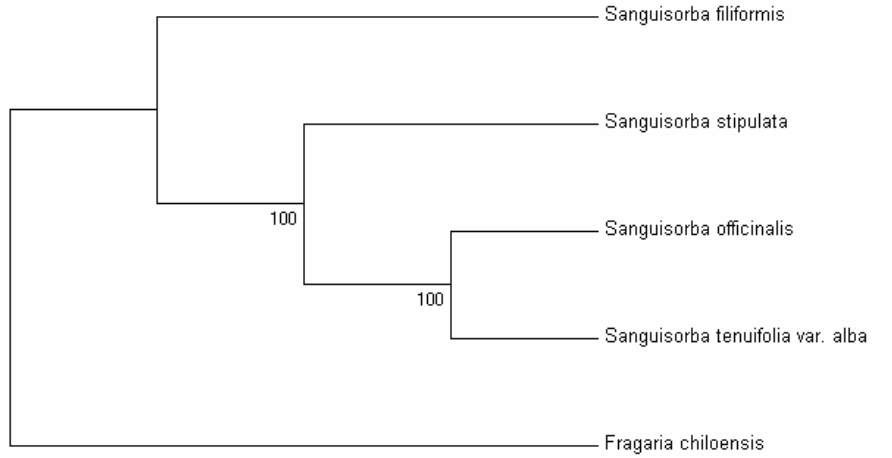
Figure 4. Phylogenetic relationships between the four Sanguisorba species determined by whole cp genome sequences using the maximum parsimony (MP) method. Fragaria chiloensis was set as the